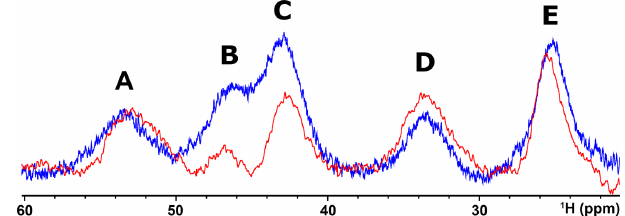
Figure A3. Efficiency of an INEPT C (cid:48) / N transfer function at differ- ent 13 C (cid:48) relaxation rates. We considered 15Hz J C (cid:48) − N and differ- ent R 2 values: (a) no relaxation, (b) 25s − 1 , (c) 50s − 1 , (d) 100s − 1 , (e) 200s − 1 , and (f) 500s − 1 . Letters have been drawn at the cor- respondence of the maximum values for each transfer function: (b ) 13.9ms, (c) 11.4ms, (d) 8.0ms, (e) 4.7ms, and (f) 2.0ms. An R 2 = 25 s − 1 was taken as a diamagnetic contribution to transverse relaxation (Charlier et al., 2016).